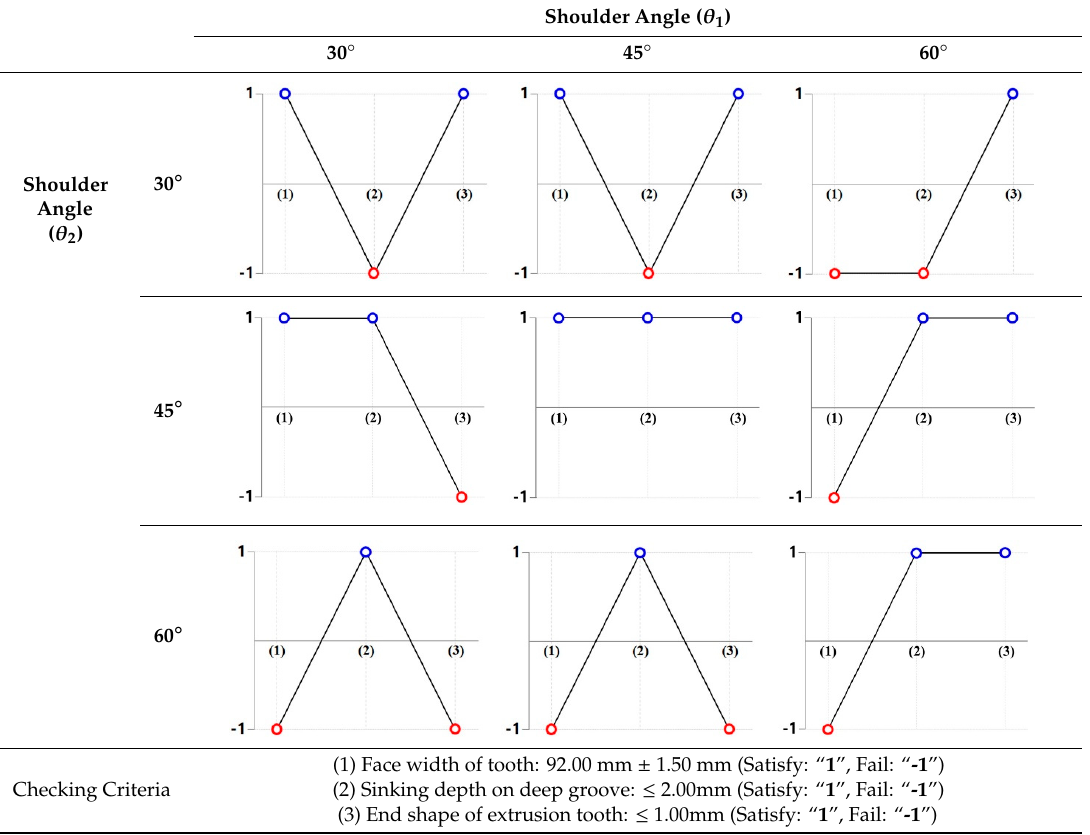
Table 3. Compatibility evaluation of the shoulder angles ( θ 1 , θ 2 ) on the extrusion dies (middle).